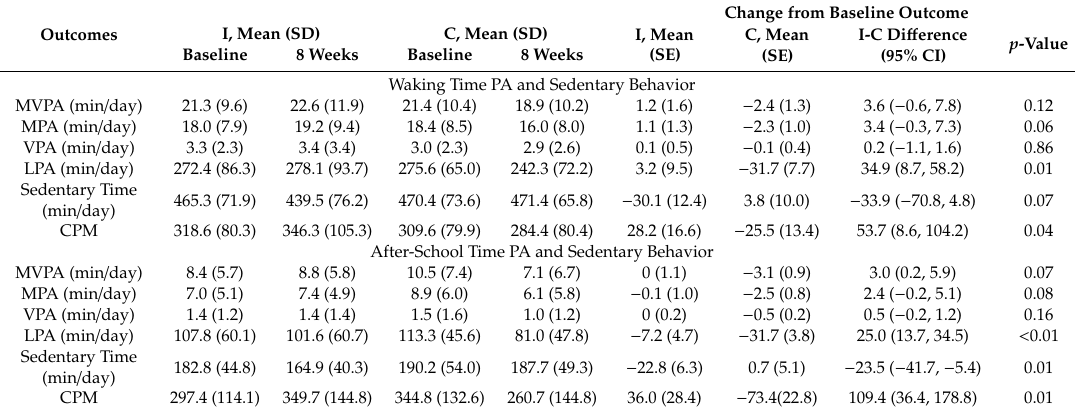
Table 2. Estimated Treatment E ff ects on Accelerometer Outcomes.